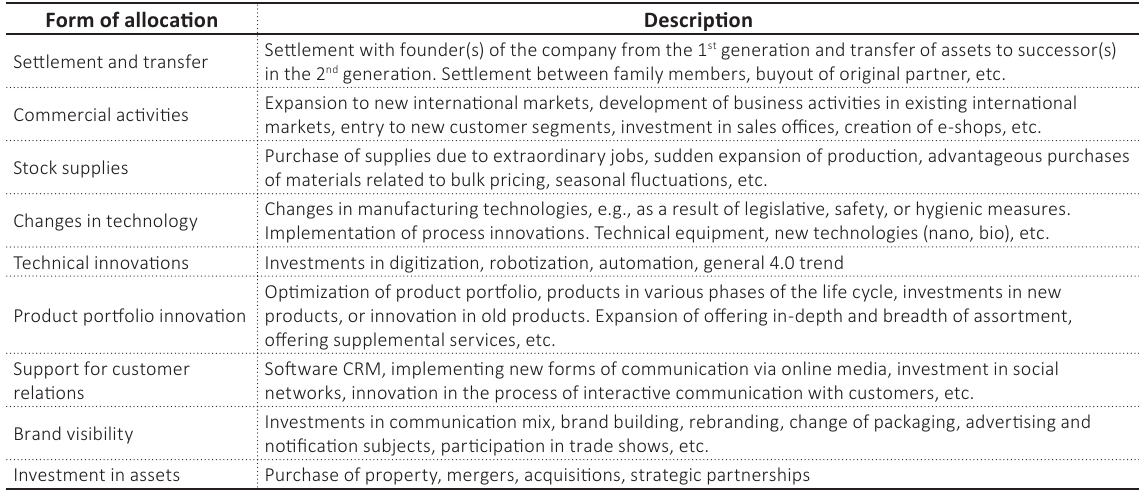
Table 3. Real need for capital